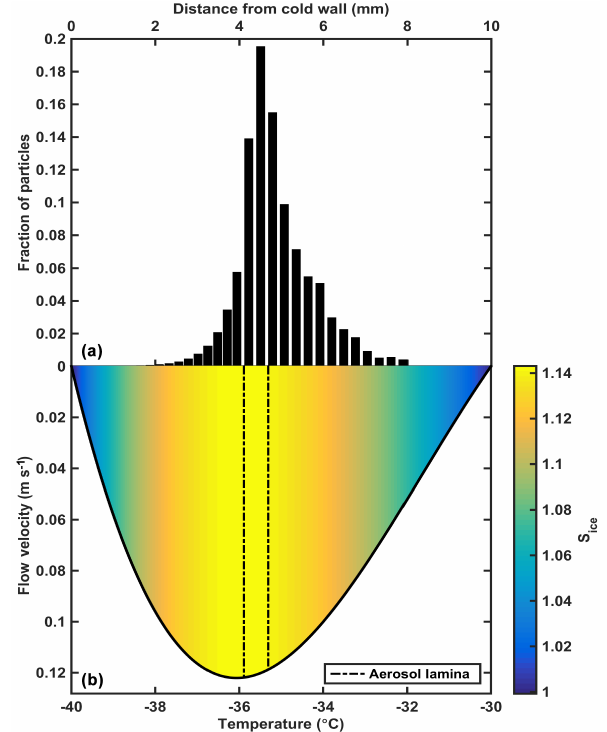
Figure 3. Measured particle distribution across the chamber in the SPIN CFDC ( a ; see text for details) corresponding to the veloc- ity profile and S ice as a function of temperature across the cham- ber (b) . The dash-dotted lines show the location of particles if they were constrained to the theoretical aerosol lamina. Note that while the peak particle concentration correctly occurs within the lamina, some particles have migrated into the sheath and are therefore ex- posed to higher and lower temperatures and supersaturation lower than the maximum.